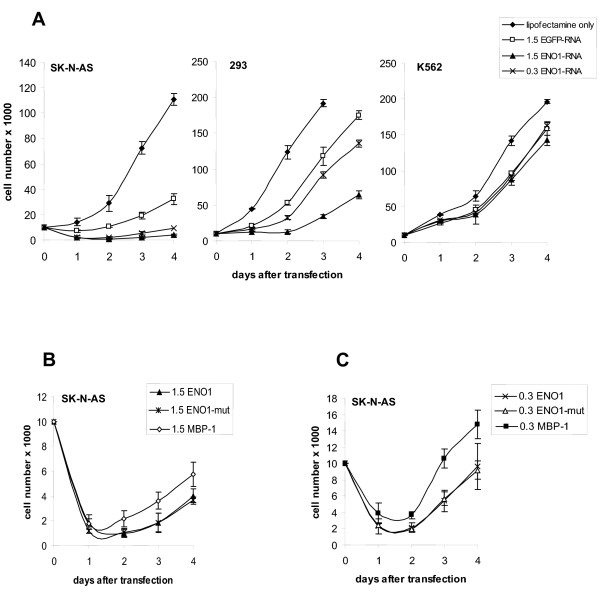
Cell growth curves of cell lines SK-N-AS, 293 and K562 after transfection of in vitro transcribed mRNA and monitoring for 4 days after transfection. The average number of cells in 8 separate experiments is shown at each time point for each construct. Standard deviation is indicated with a bar. A: Two different amounts of mRNA have been used for ENO1-mRNA: 1.5 (1.5 μg ENO1-mRNA) or 0.3 (0.3 μg ENO1-mRNA + 1.2 μg EGFP-mRNA), compared to 1.5 μg EGFP-mRNA and lipofectamine only. There is strong statistical significance (p << 0.001) for difference in cell numbers between the ENO1-mRNA-experiments and the EGFP-mRNA experiments in SK-N-AS and 293-cells (exact p-values for each day are listed in Table 3), in K562 cells the difference was not significant. B: Cell growth curves of SK-N-AS cells after transfection of 1.5 μg of ENO1, ENO1-mut and MBP-1 mRNAs and monitoring for 4 days. The difference in cell numbers between ENO1 and MBP-1 was significant for day 2–4 (p = 0.02), ENO1 and ENO1-mut did not significantly differ. C: Cell growth curves of SK-N-AS cells after transfection of 0.3 μg ENO1, ENO1-mut and MBP-1 mRNAs and monitoring for 4 days. The difference in cell numbers between ENO1 and MBP-1 was significant for day 2 (p = 0.006), 3 (p = 0.001) and 4 (p = 0.02). ENO1 and ENO1-mut did not significantly differ.